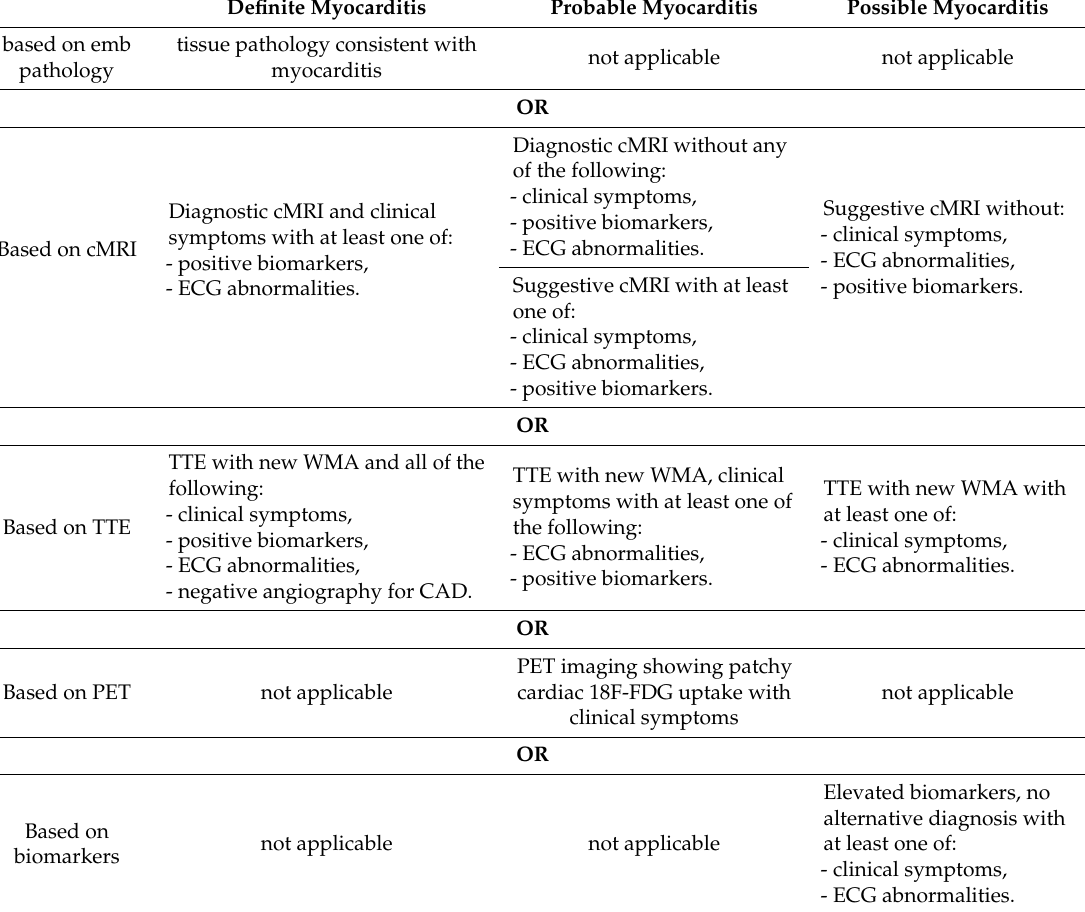
Table 2. Proposed division of myocarditis into definite, probable, or possible (modified according to Bonaca et al. [80]). The hierarchical definition reflects a gradually decreasing level of